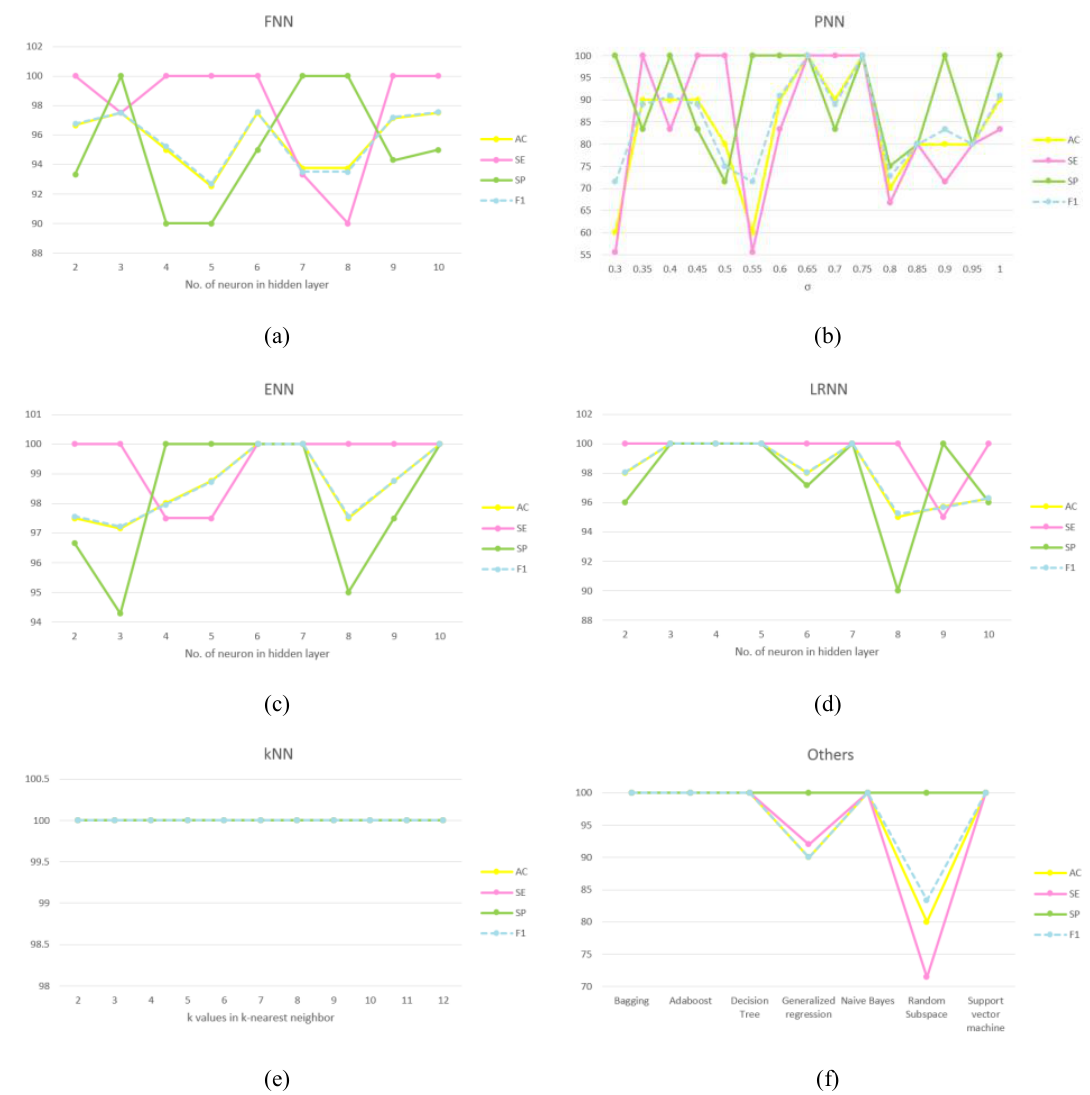
Figure 5. The Performance of Different ML Schemes in Discrimination Between COPD and Controls Using 8-Fold CV. (a) FNN, (b) PNN, (c) ENN, (d) LRNN, (e) kNN, and (f) other remaining approaches, including DT, EMs, GRNN, SVM, and NB. Note . ML: Machine learning; COPD: Chronic obstructive pulmonary disease; CV: Cross-validation; FNN: Feed-forward neural network; PNN: Probabilistic neural network; ENN: Elman neural network; LRNN: Layer recurrent neural network; kNN: k-nearest neighbor; DT: Decision tree; EM: Ensemble method; GRNN: Generalized regression neural network; SVM: Support vector machine; NB: Naive